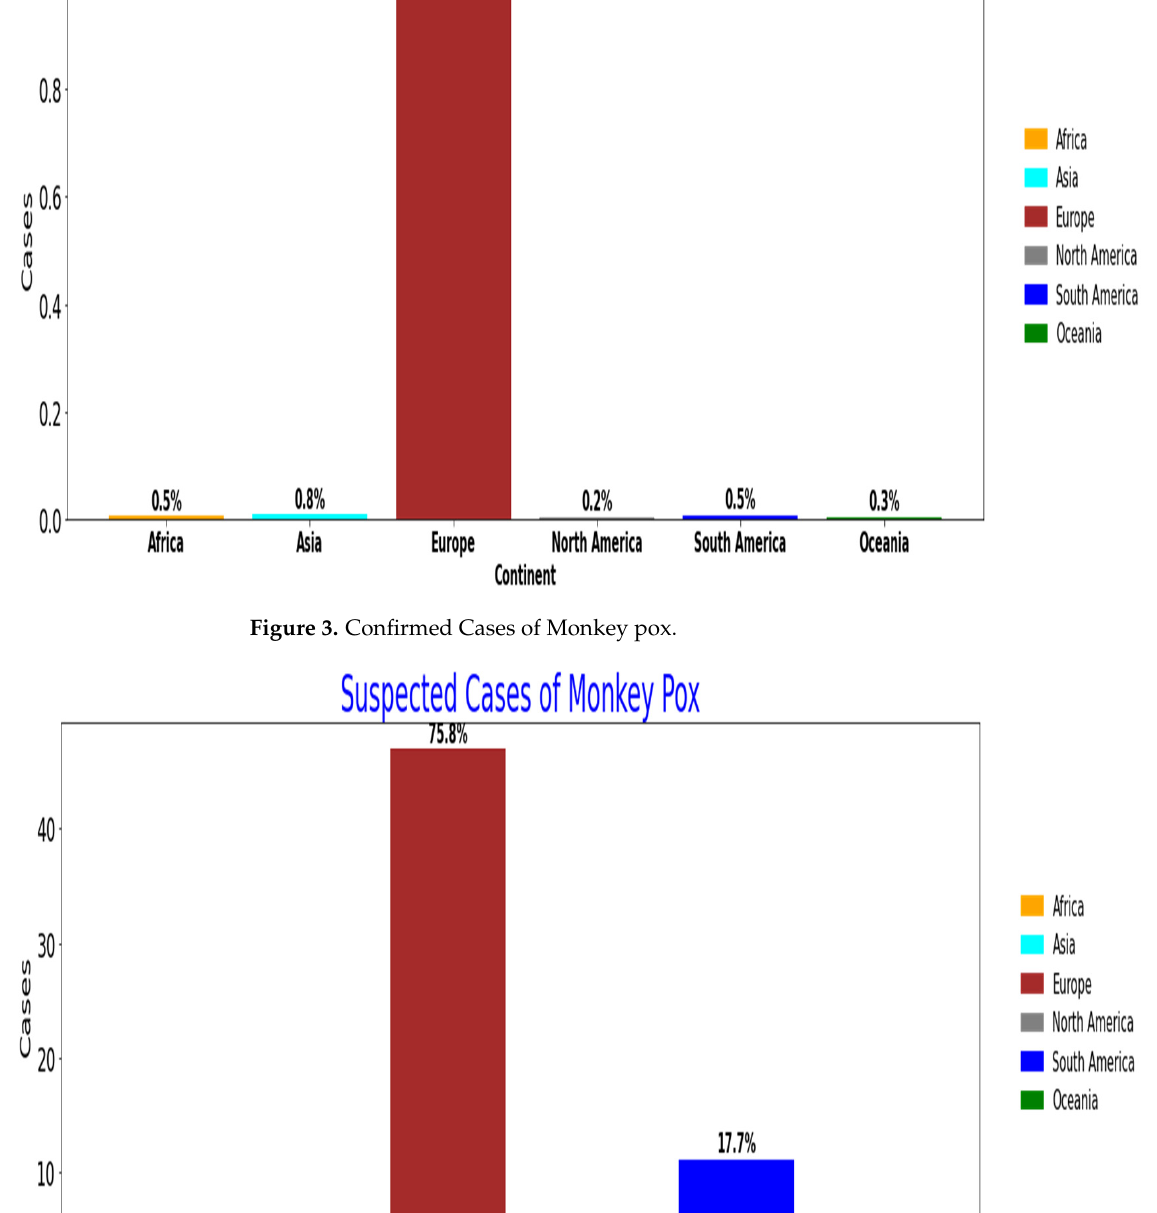
Figure 2. Hospitalized Cases of Monkey Pox.